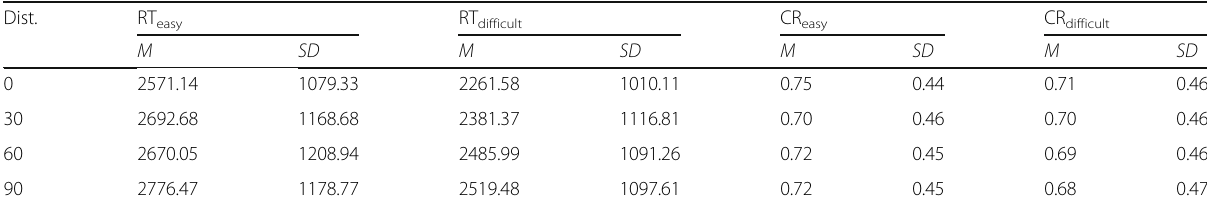
Table 2 Descriptive values of correct responses and reaction time for levels of distortion in conditions